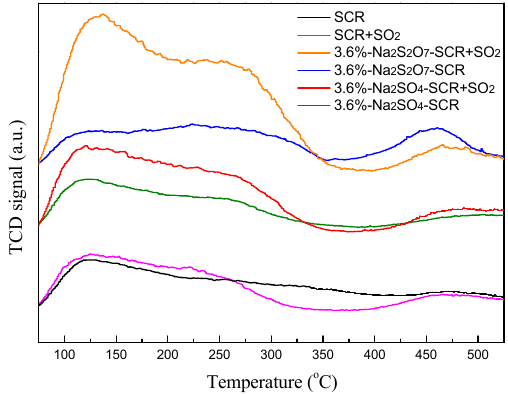
Figure 6. NH 3 -TPD profiles of the catalysts in different SO 2 concentration (0 and 1800 ppm).